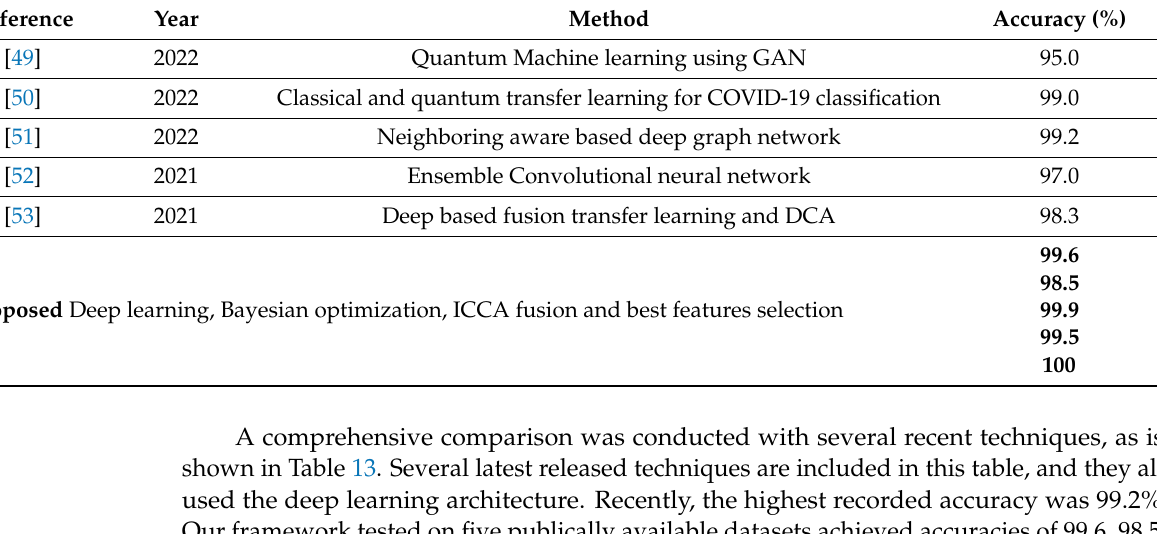
Table 13. Proposed approach comparison with latest